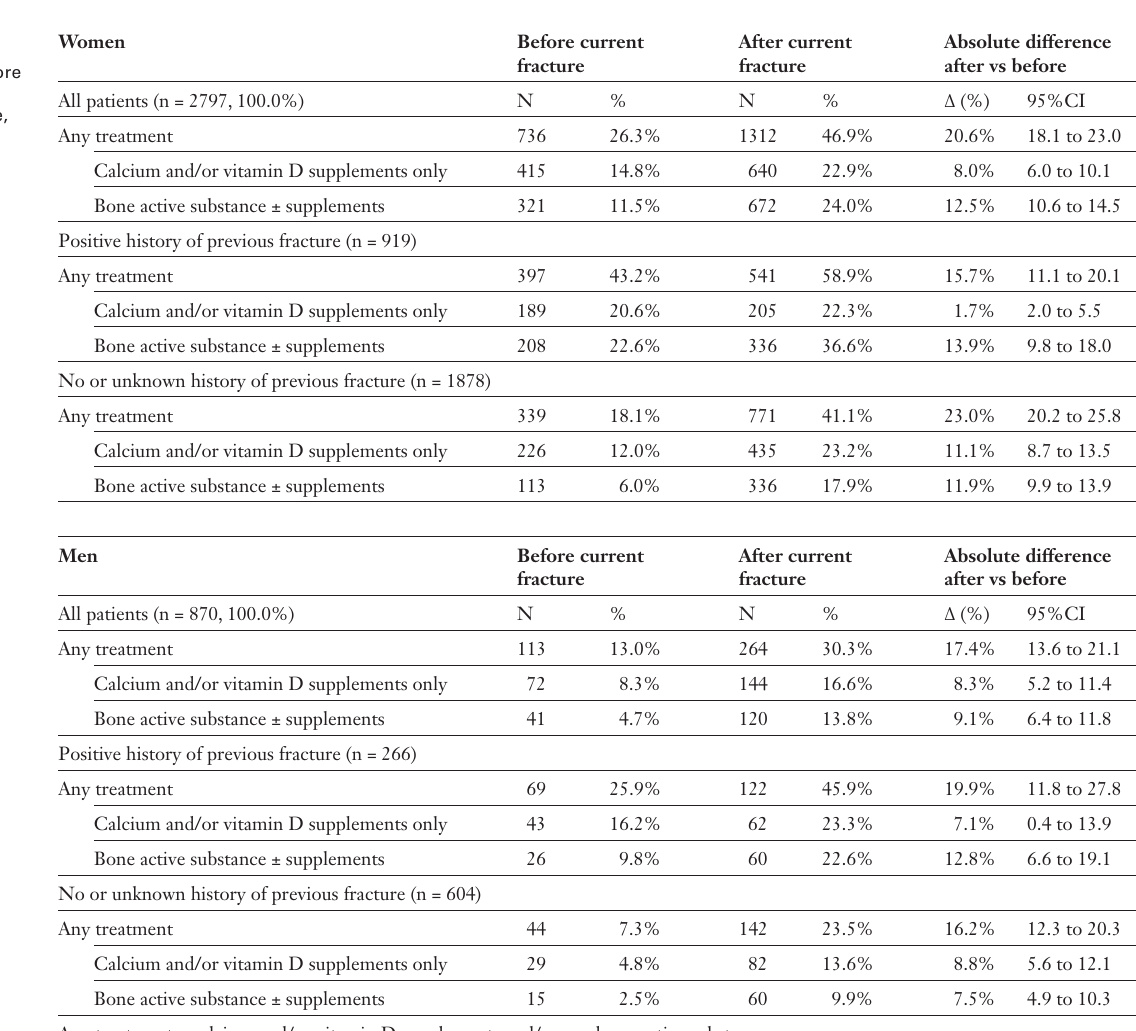
table 2. Patients with a positive history of previ-